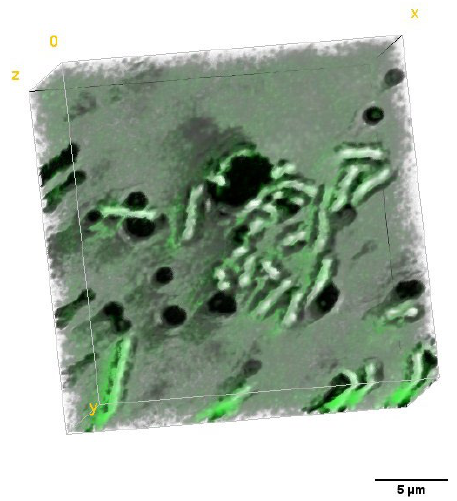
Figure 9. Ce6 aggregates localization performed by fluorescence confocal microscopy for E. coli cells after 48 h incubation with PS.